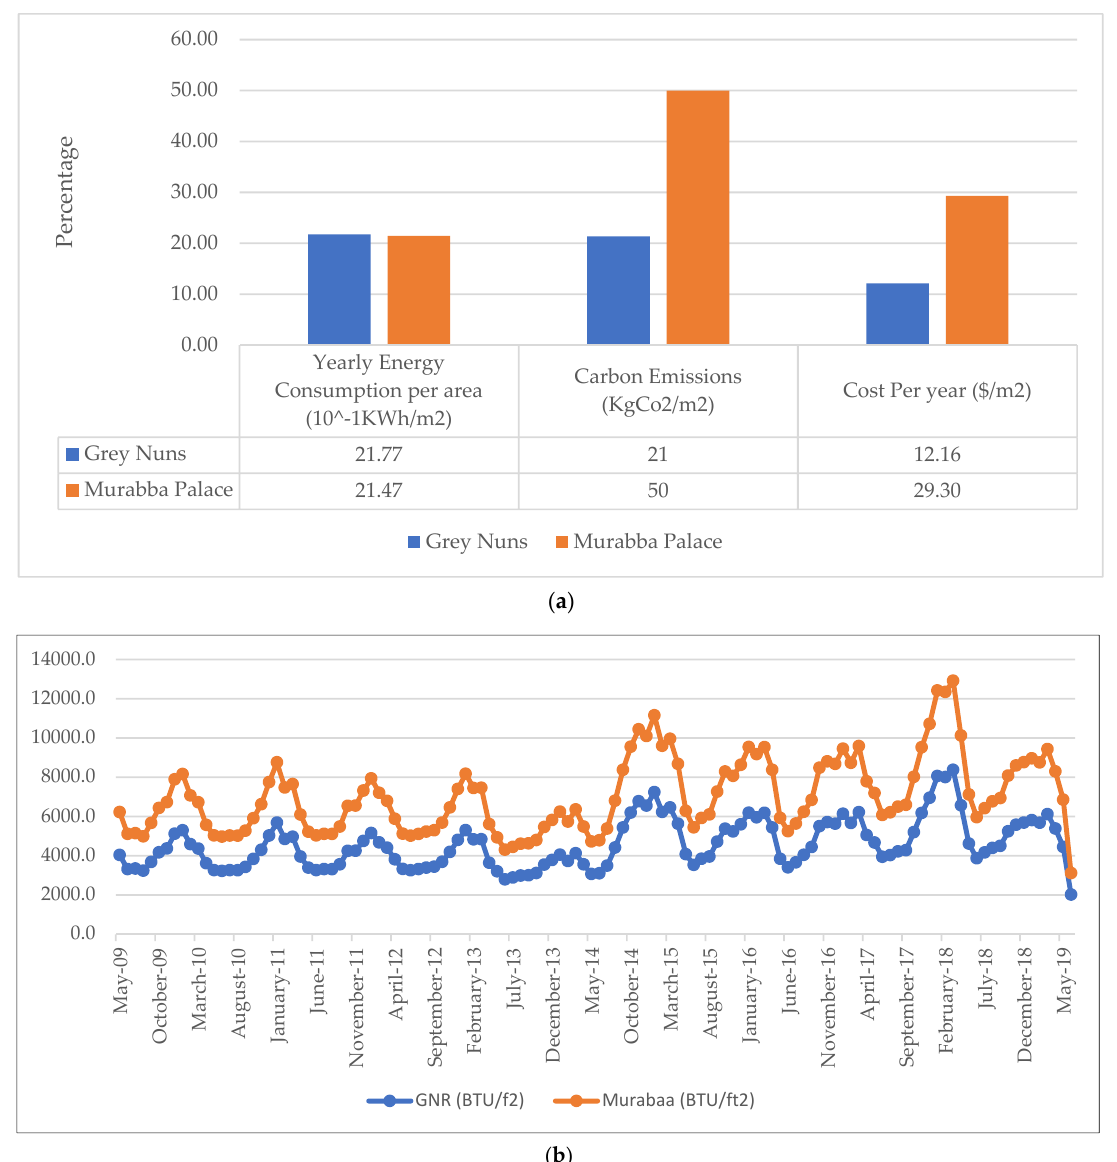
Figure 6. Energy and carbon consumption. ( a ) Energy, carbon consumption, and cost per m 2 . ( b ) Energy consumption for Murabba Palace and Grey Nuns Building.